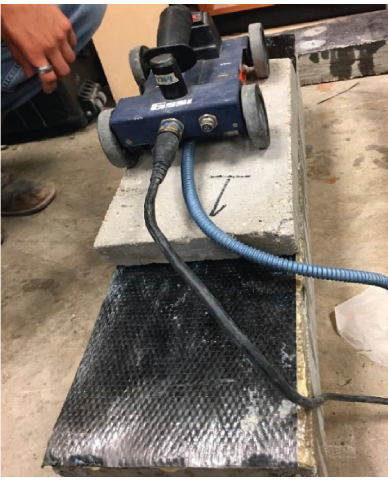
Figure 9: GPR scanning of